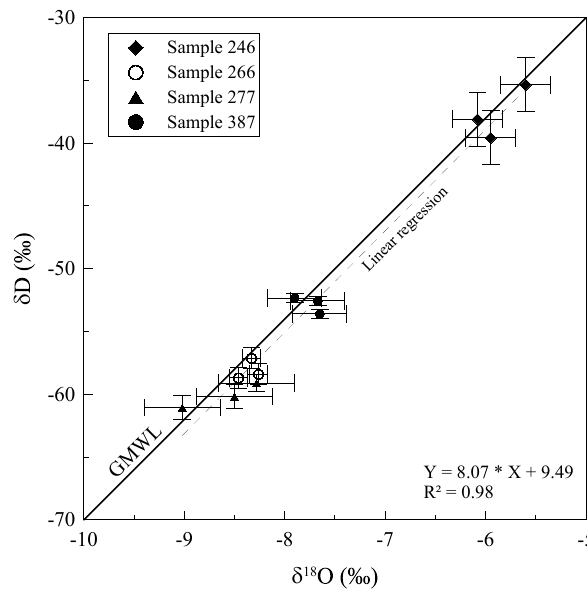
Figure 12. δD vs. δ 18 O measurements with standard deviations based on three replicates for speleothem samples from Borneo. Re- sults are close to the Global Meteoric Water Line (GMWL), which is similar to the meteoric water line of Borneo (Moerman et al., 2013).